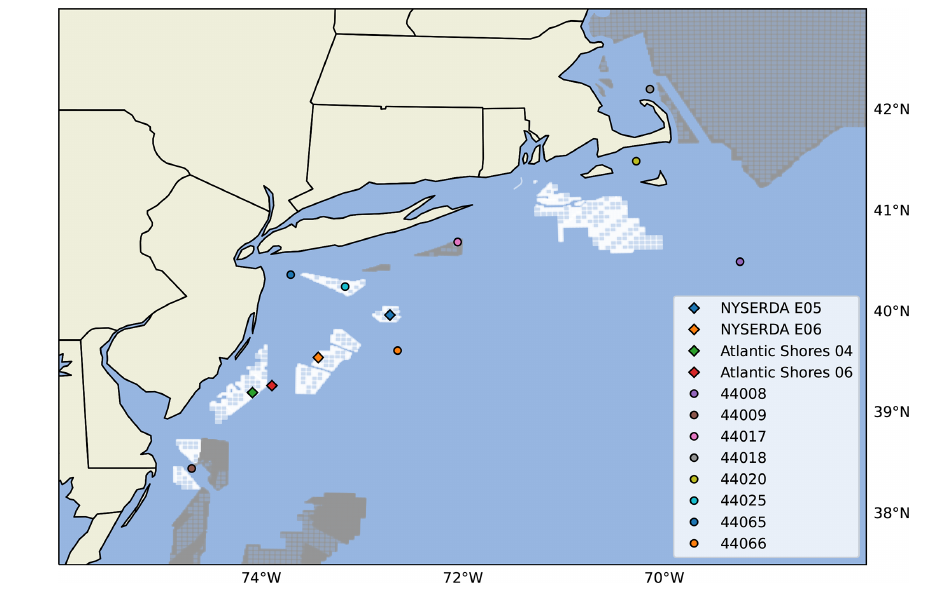
Figure 1. Map of the observational data sets used in the analysis. Lidar locations are shown as diamonds, NDBC buoys are shown as dots. Wind lease areas are shown in white and wind planning areas in gray. The distance between the two NYSERDA lidars is about 75km, the two Atlantic Shores lidars are about 20km from each other, and finally the distance between the NYSERDA E05 and Atlantic Shores 04 lidars is about 145km.